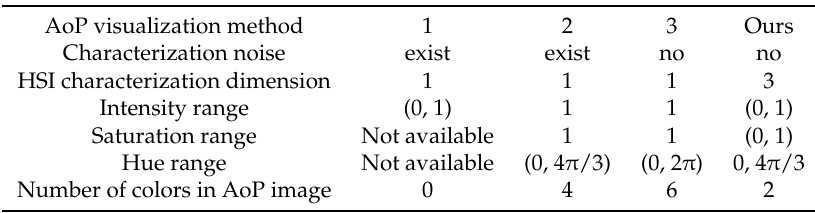
Table 1. Comparison of AoP visualization